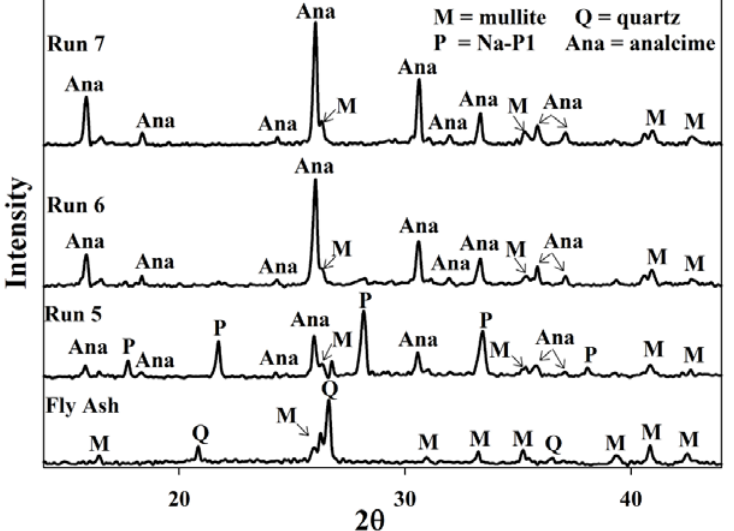
Figure 5. Powder X-ray diffraction patterns of products obtained after synthesis with supernatant waste as NaOH source after adjusting the pH of the waste. Run 5 Baseline run using fresh NaOH solution. Run 6 synthesis using waste supernatant from Run 5 as NaOH source. Run 7 synthesis using supernatant waste from Run 6 as NaOH source.